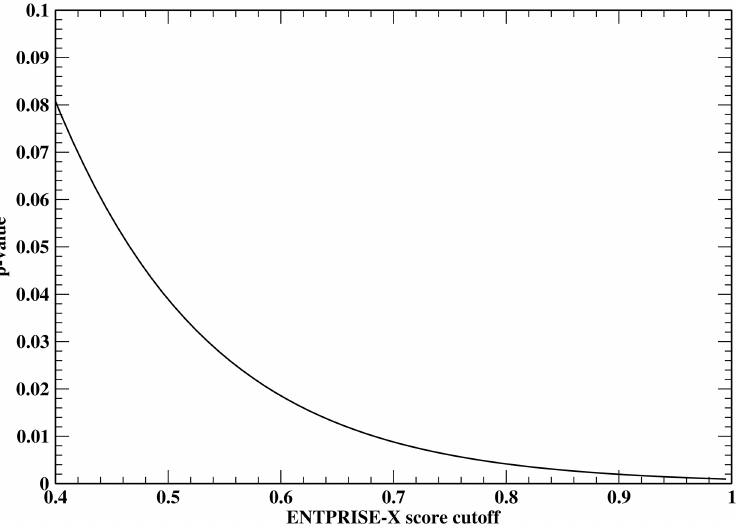
Fig 4. P-value derived from the VEST-indel test set by fitting to an extreme value distribution versus ENTPRISE-X score cutoffs.